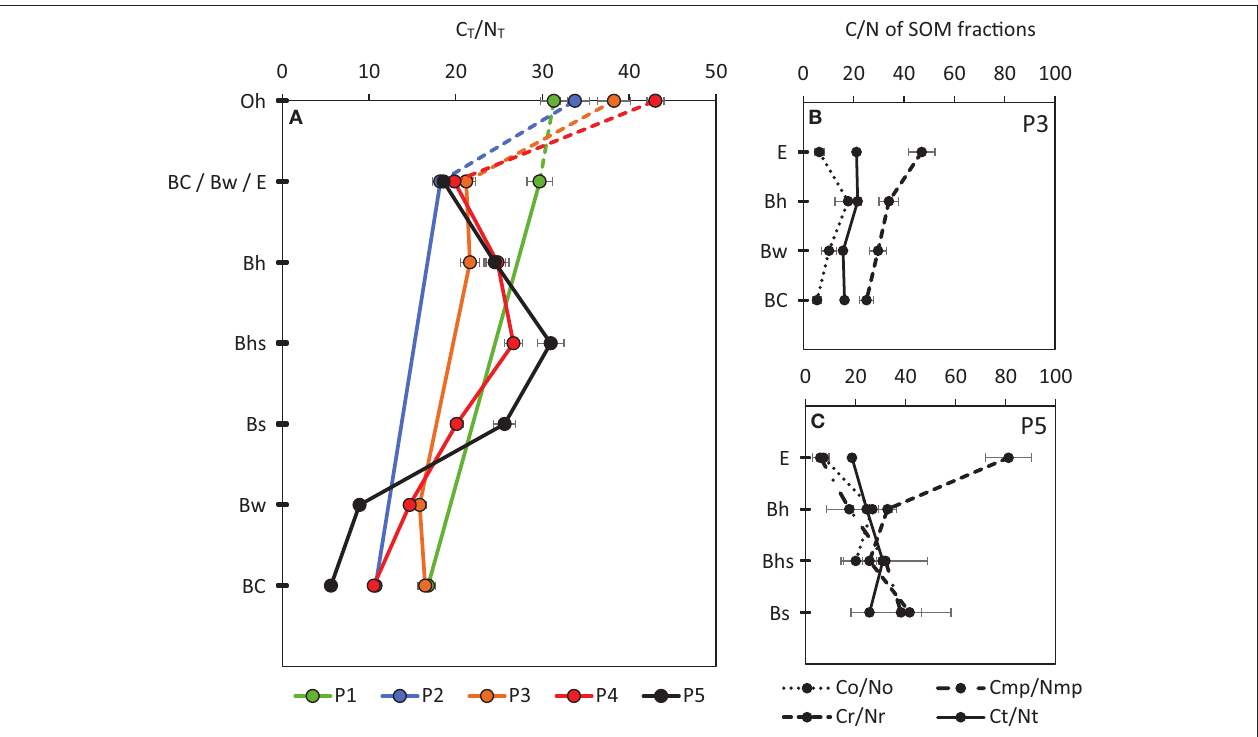
FIGURE 4 | (A) Evolution of the C T /N T ratio of the 5 profiles of increasing age: P1–120 years, P2–175 years, P3–270 years, P4–330 years, and P5–530 years. Evolution of the C/N ratio of the SOM fractions [total (C T /N T ), recalcitrant (C R /N R ), oxidizable (C O /N O ) and mineral-protected (C MP /N MP ) carbon fraction], in the four first horizons of P3 (B) and P5 (C) profiles (error bars represent ± one standard deviation).